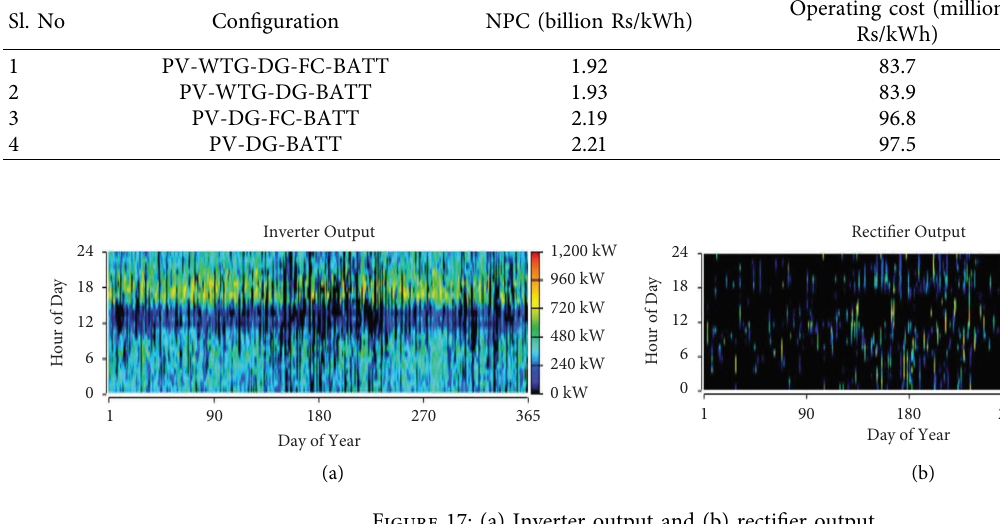
Figure 17: (a) Inverter output and (b) rectifer output.